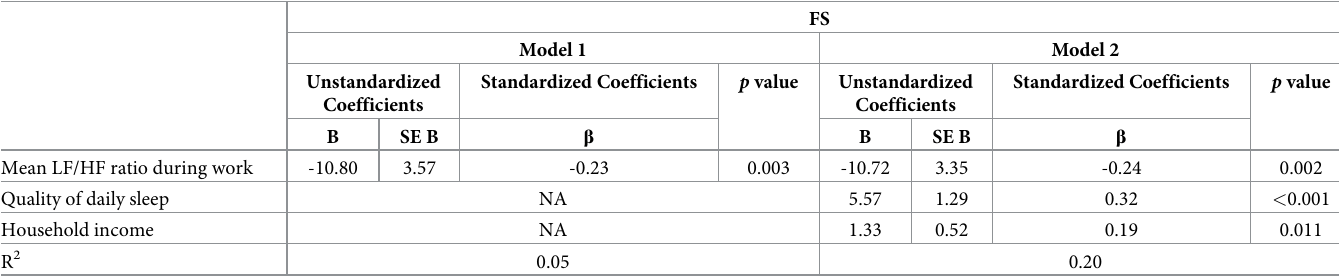
Table 6. Effect of the LF/HF ratio on FS.